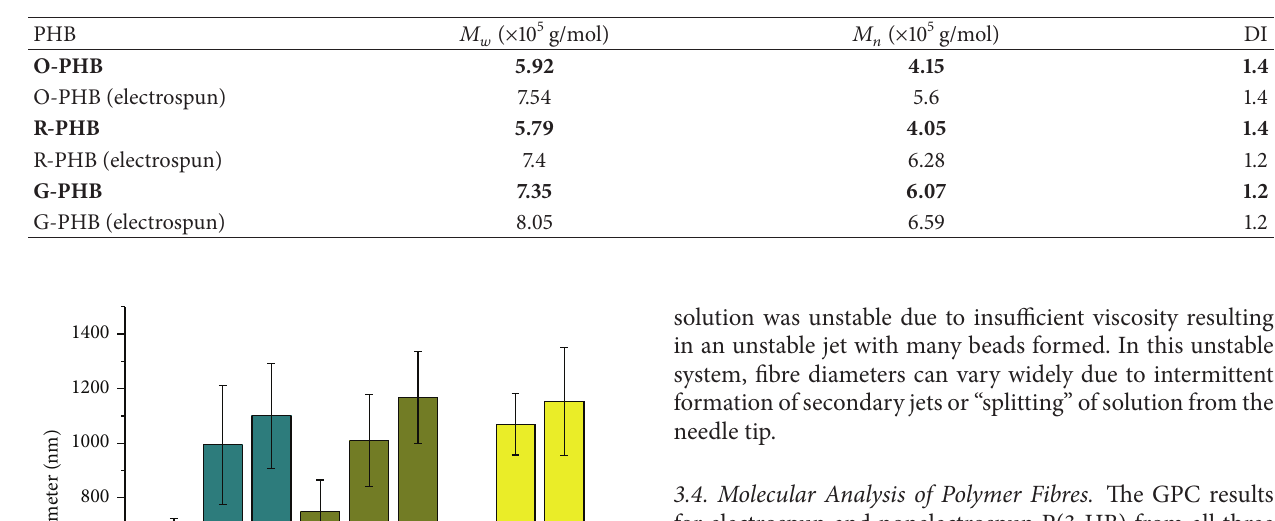
Table 2: The 𝑀 𝑤 , 𝑀 𝑛 , and DI of electrospun and nonelectrospun PHB from olive oil, rapeseed oil, and glucose ( 𝑀 𝑤 : weight average molecular